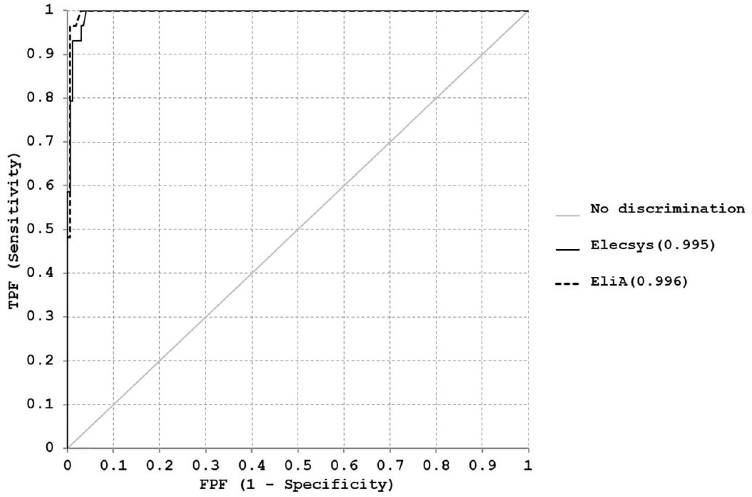
Fig 5. ROC (Receiver operating curve) analysis for EliA ™ and Elecsys 1 . ROC curve of both methods at manufacturer cut-off values.